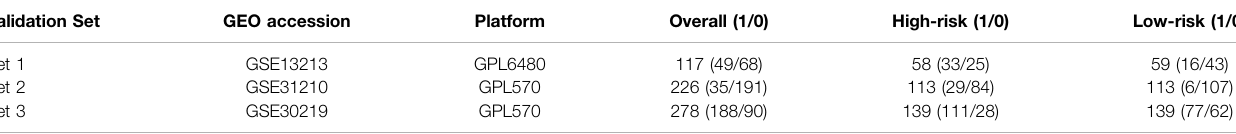
TABLE 2 | Information of GEO data sets used in the validation of the Cox model. Validation Set GEO accession